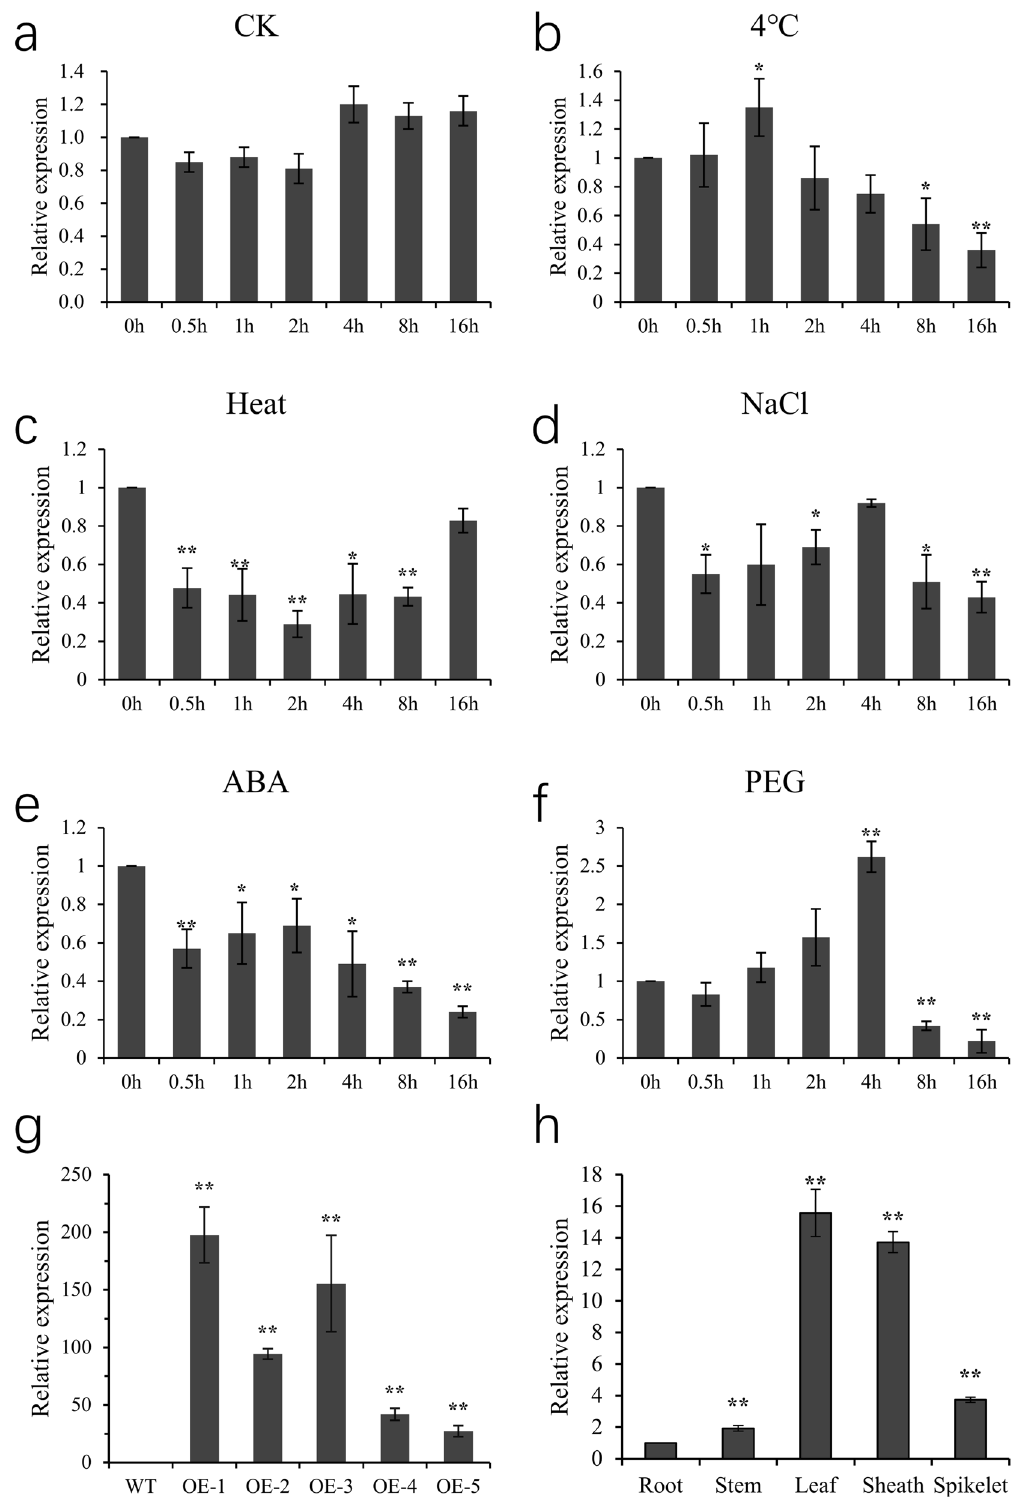
Figure 2. ( a – f ) OsSCL30 gene expression pattern under various environmental stresses and ABA treatment. (a. ck; b. 4 °C; c. 42 °C; d. 150 mM NaCl; e. 50 μM ABA; f. 15% w/v PEG) ( g ) OsSCL30 transgenic lines expression detection. ( h ) Tissue expression of OsSCL30 . Error bars represent ± SE (n = 3). Asterisks indicate significant differences ( * P < 0.05, ** P <